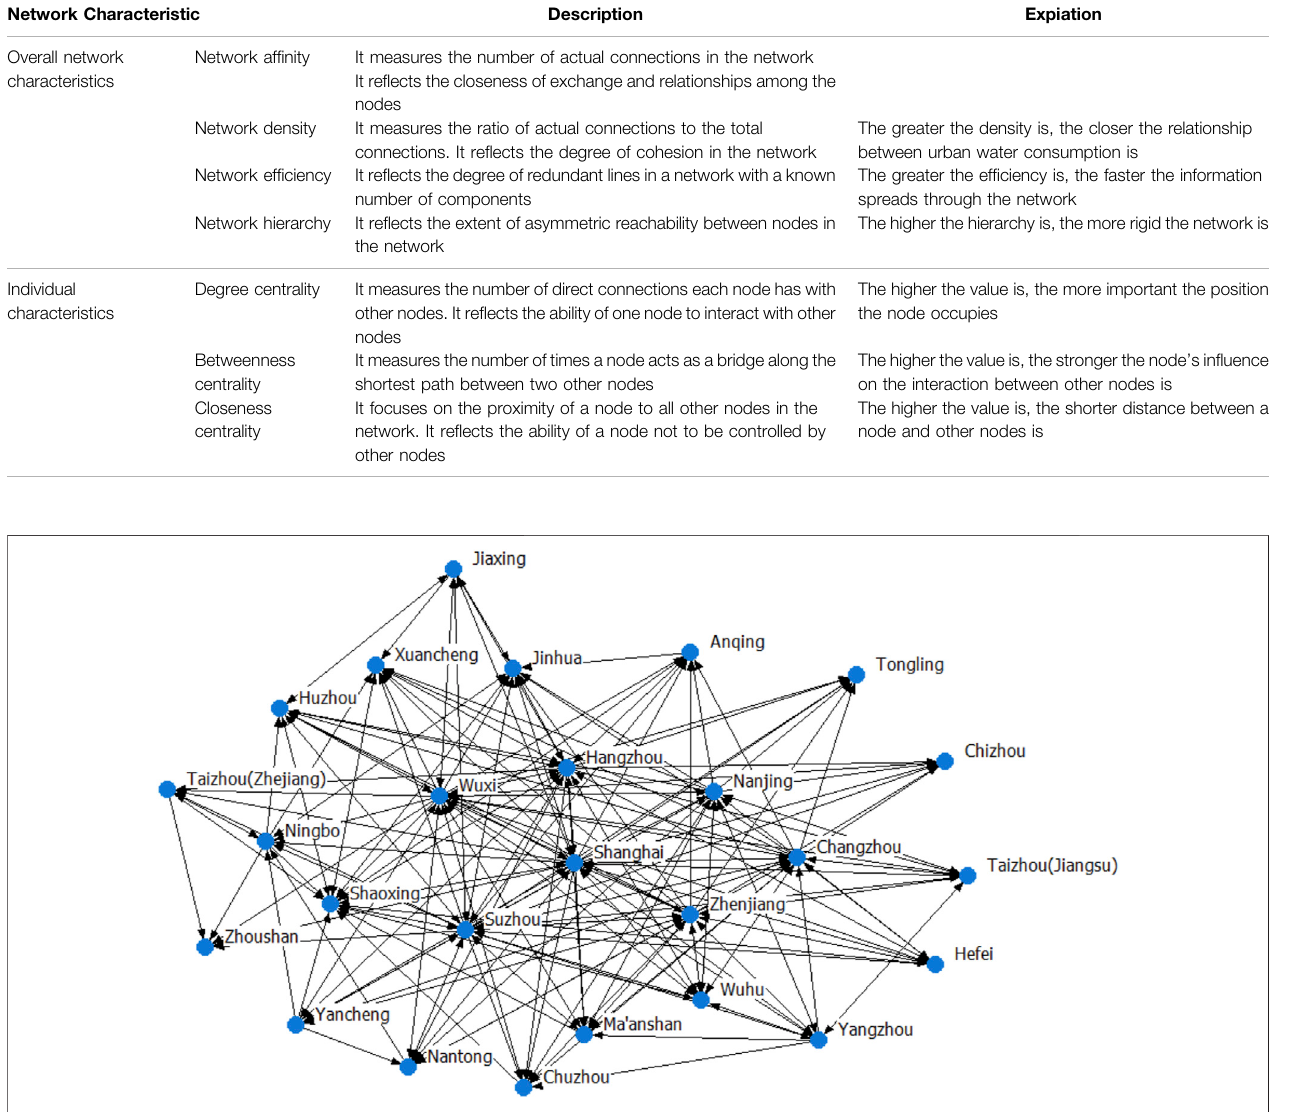
FIGURE 3 | Water consumption spatial correlation network of the YRDUA in 2020.